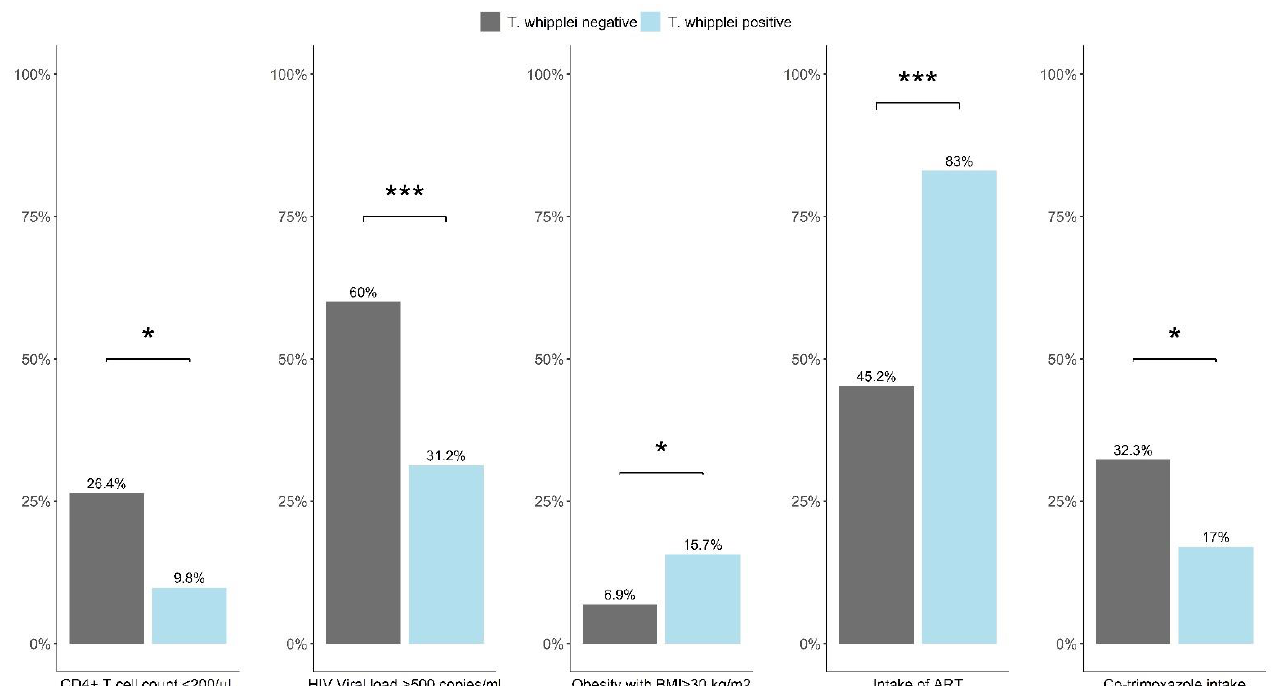
Figure 2. Laboratory, medical, and treatment-related parameters according to T. whipplei status among HIV positive participants. BMI—Body mass index; ART—antiretroviral therapy; *— p < 0.05; ***— p < 0.001. Table 2. Virological and immunological parameters according to T. whipplei